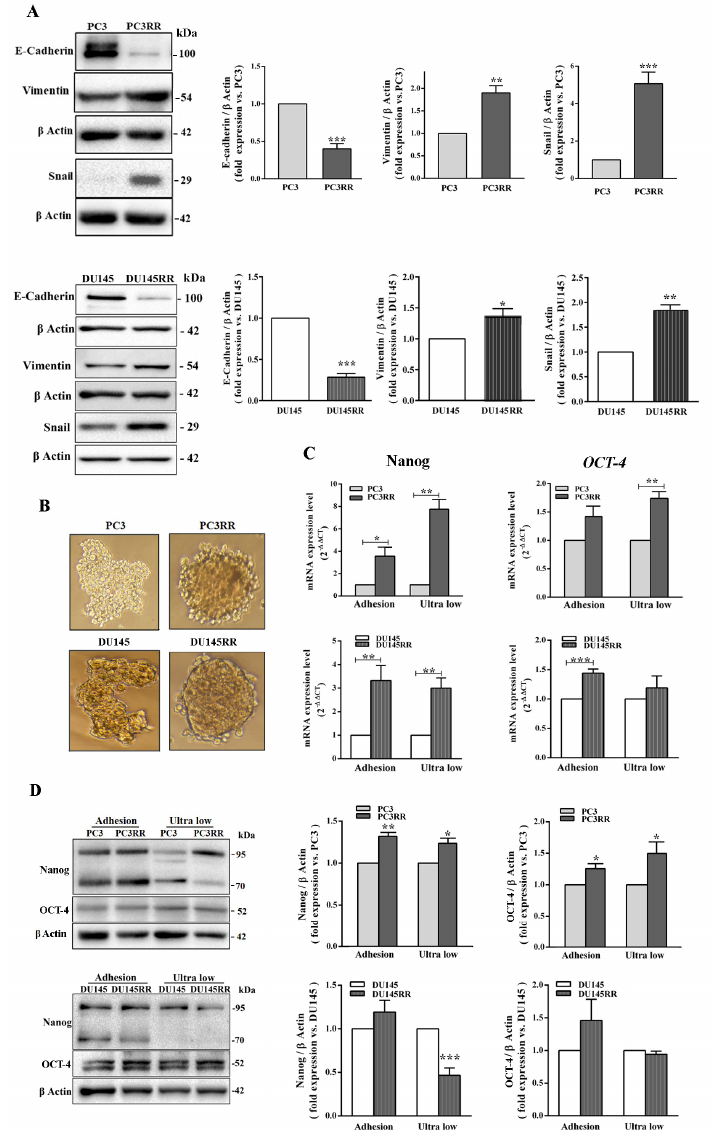
Figure 8. Evaluation of epithelial–mesenchymal transition and stem cell markers in parental PCa and PCaRR cell lines. ( A ) Whole cell extracts were analyzed using Western blot for the indicated epithelial or mesenchymal markers. Each blot is representative of at least three. The histograms represent the densitometric analysis of the Western blot, showing fold expression of each protein normalized with β -Actin (parental PC3 and DU-145 cell value set as one). Data are from at least three separate experiments. ( B ) Phase contrast micrographs of PC3/PC3RR and DU-145/DU-145RR cells cultured in anchorage-independent conditions for 96 and 48 h, respectively. ( C ) The histograms represent the mRNA expression of OCT-4 and Nanog genes assayed by RT-qPCR in PC3/PC3RR and DU-145/DU-145RR cells after 96 and 48 h in adherent or anchorage-independent (ultra-low) conditions, respectively. ( D ) Western blot of PC3/PC3RR and DU-145/DU-145RR cells in the same conditions as in ( C ). Each blot is representative of at least three experiments. The histograms show the densitometric analysis of Western blots, representing the fold expression of the OCT-4 or Nanog (parental PC3 and DU-145 cells value set as one). β -Actin was used as the control for equal amounts of loaded proteins. Data represent the mean ± S.E.M. derived from at least three independent experiments; PC3RR vs. PC3 and DU-145RR vs. DU-145, * p < 0.05; ** p < 0.01; *** p < 0.001, Student’s unpaired t